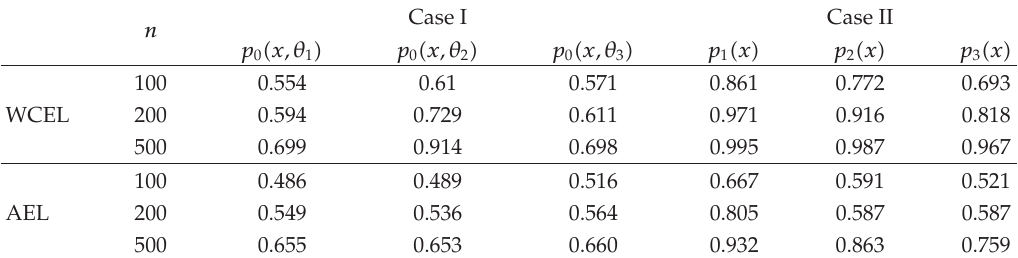
Table 1: Empirical coverage probabilities of the confidence regions for β under di ff erent selection proba- bility functions p (cid:6) x (cid:7) and sample sizes n when nominal level is